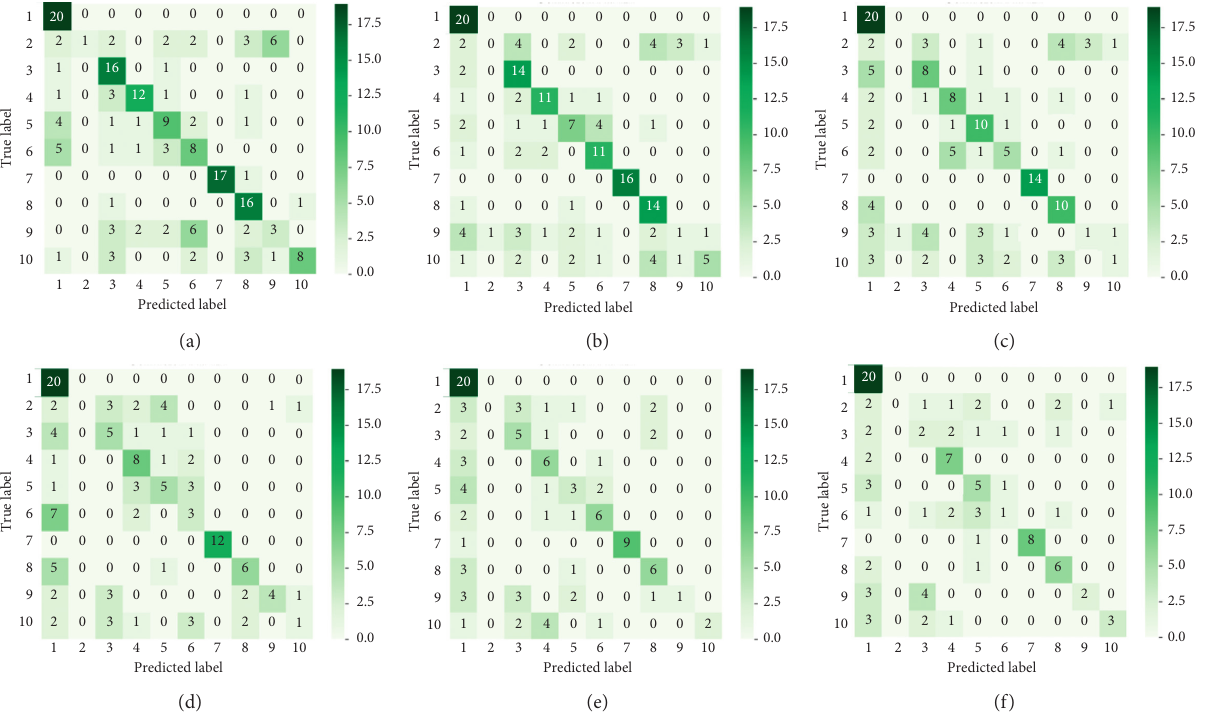
Figure 14: Confusion matrices of FNN for the ten-classes scenario in different cases. (a) Case 2. (b) Case 3. (c) Case 4. (d) Case 5. (e) Case 6. (f) Case 7.